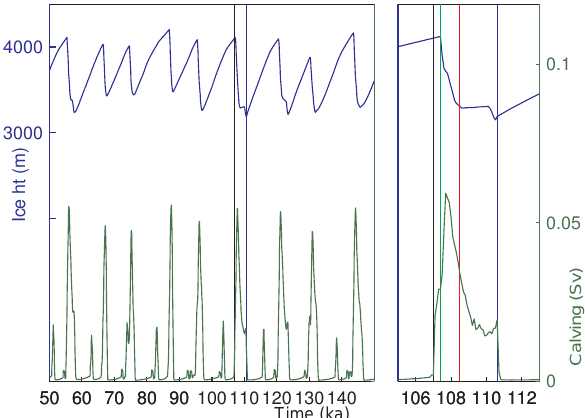
Figure 3. Variability in the ice sheet over Hudson Bay and Hud- son Strait. The upper curve shows the average height of the ice sheet over central Hudson Bay (m, blue box in Fig. 2); the lower curve is the flux of ice out of the mouth of Hudson Strait (1Sv = 1 × 10 6 m 3 s − 1 ). The left panel shows results for 100000 years of model run; the right panel zooms in on the event between 105 and